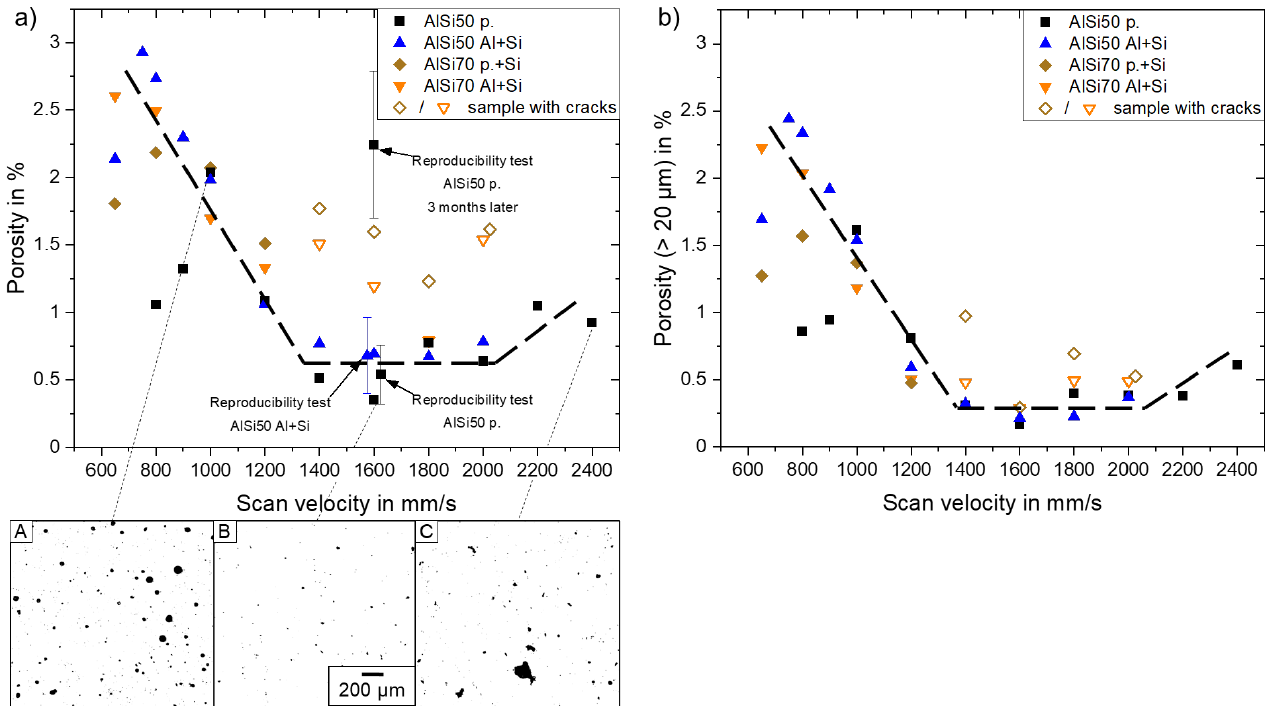
Figure 2. ( a ) Porosity vs. scan velocity for AlSi50 and AlSi70 samples built from different powder types. Binary images of AlSi50 p. samples built with 1000 mm/s (A), 1600 mm/s (B) and 2400 mm/s der types. Binary images of AlSi50 p. samples built with 1000 mm/s ( A ), 1600 mm/s ( B ) and (C). ( b ) Same as ( a ), but only pores with diameter > 20 µm were considered. 2400 mm/s ( C ). ( b ) Same as ( a ), but only pores with diameter >20 µ m were